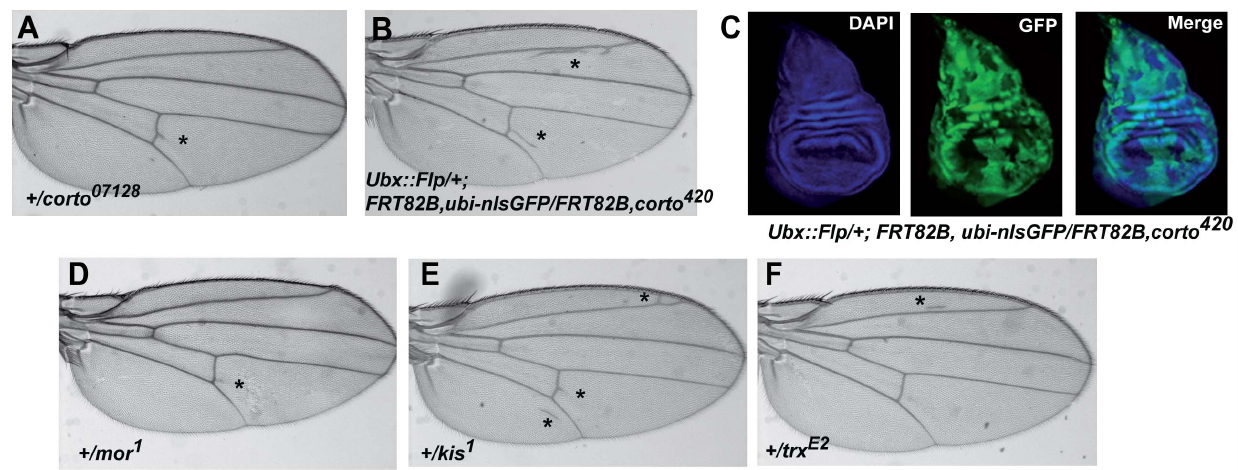
Figure 6. corto and several TrxG genes control wing cell identity. (A, B): Ectopic vein phenotypes induced by the corto 07128 loss-of-function allele (A) or by corto 420 loss-of-function clones (B). (C): corto 420 homozygous clones (GFP - cells) in wing imaginal discs. (D, E, F): Ectopic vein phenotypes induced by mor , kis or trx loss-of-function alleles. In A, B, D, E, F, asterisks mark ectopic veins.